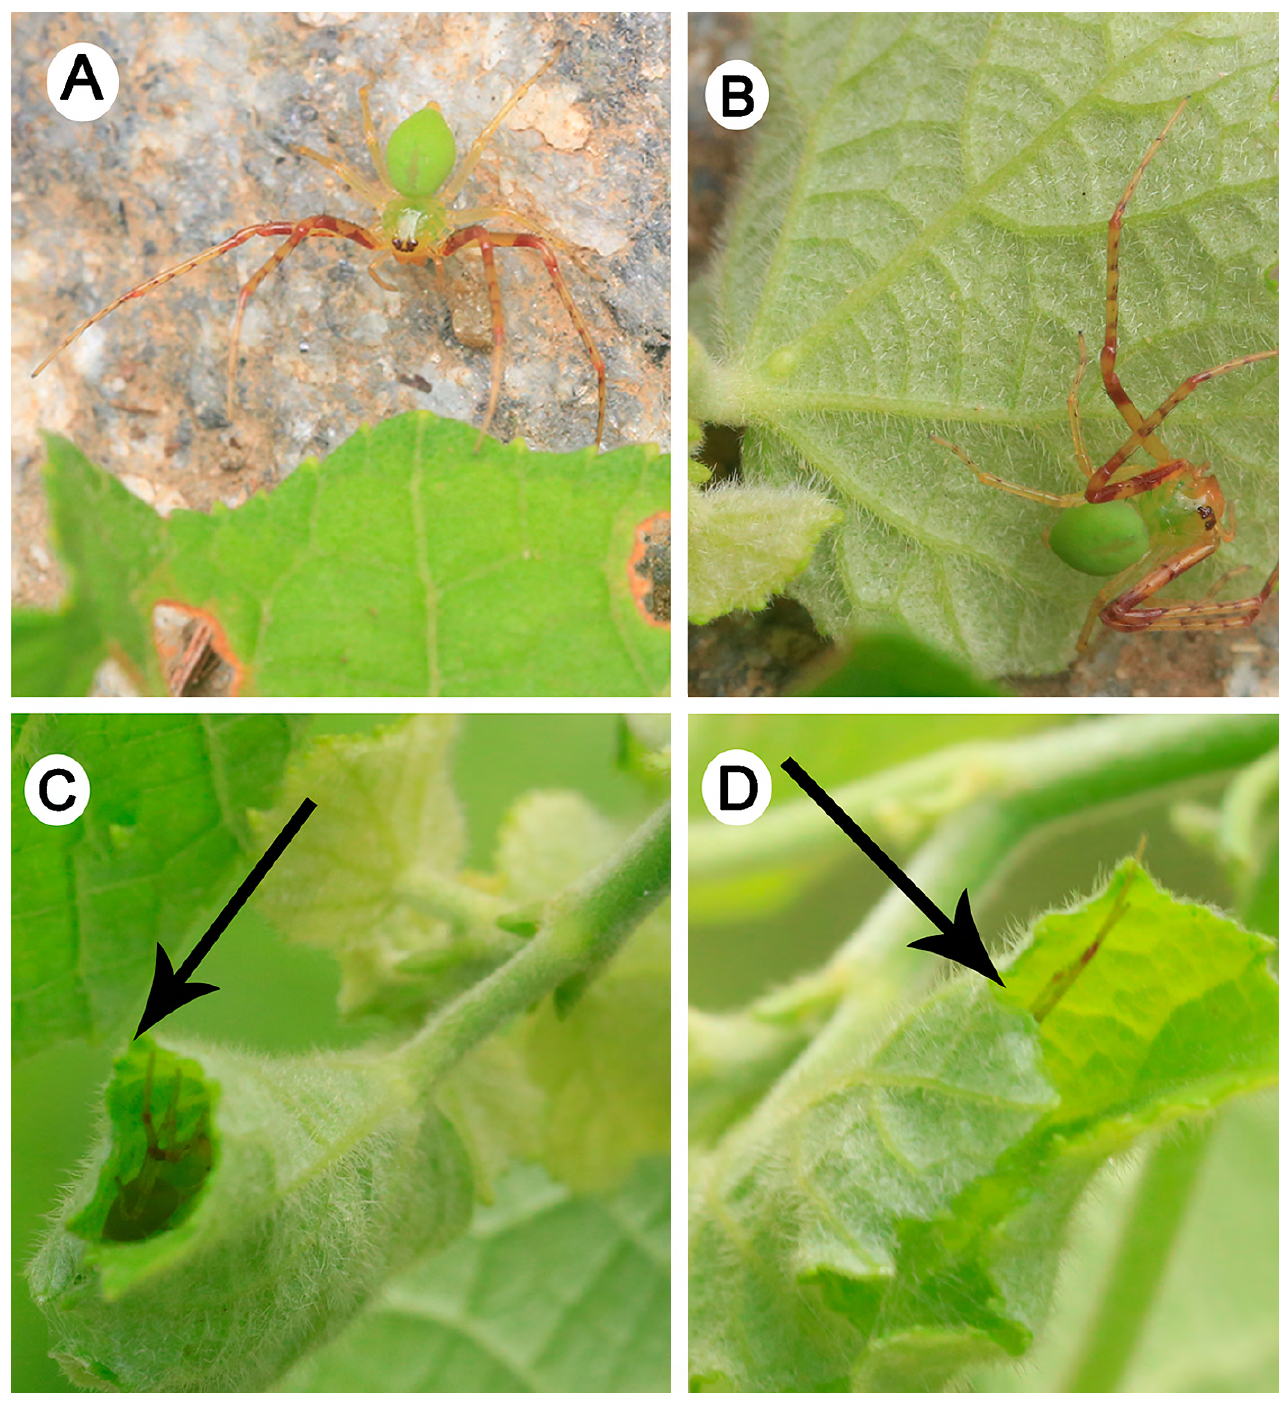
Figure 2. A, B. Live female Epidius parvati Benjamin, 2000. C, D. Hiding place of the spiders among